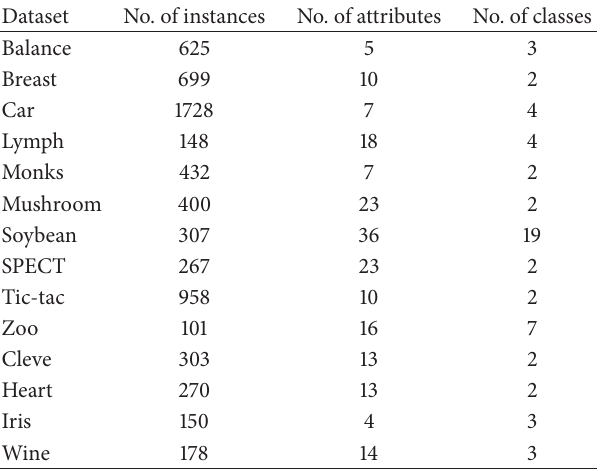
Table 1: Characteristics of UCI